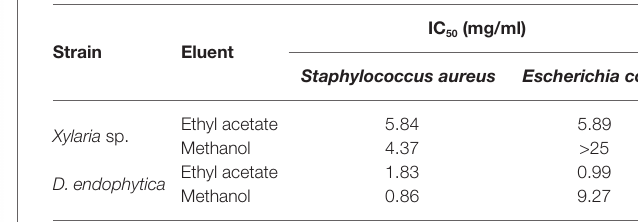
TABLE 3 | IC 50 for fractions obtained by alternative extraction with polymeric resin Amberlite X.A.D. 16 N of Xylaria sp. and D. endophytica against tested